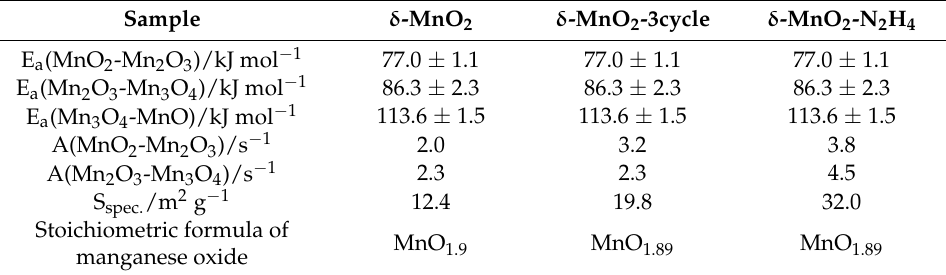
Figure 4. Activation energy vs. conversion degree ( α ) curves obtained by Friedman method. ( a )— δ -MnO 2 ; ( b )— δ -MnO 2 -3cycle; ( c )— δ -MnO 2 -N 2 H 4 . Table 1. Optimized kinetic parameters of birnessite reduction and BET specific surface areas.